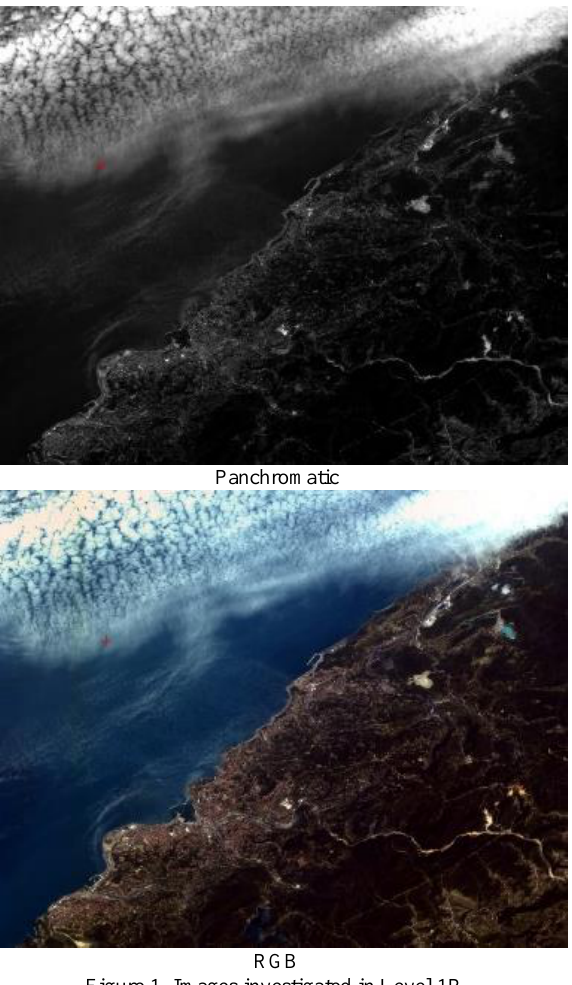
Figure 3. Noise and SNR for Level 1.